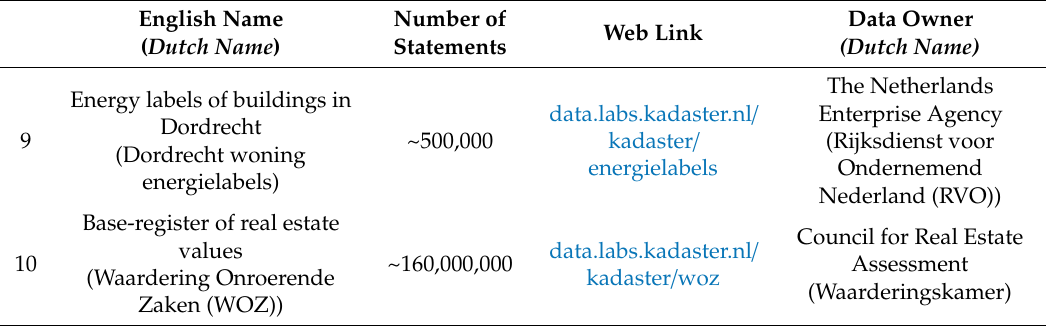
Table 3. KKG data sources published in the experimental environment of Kadaster. (Source: authors).